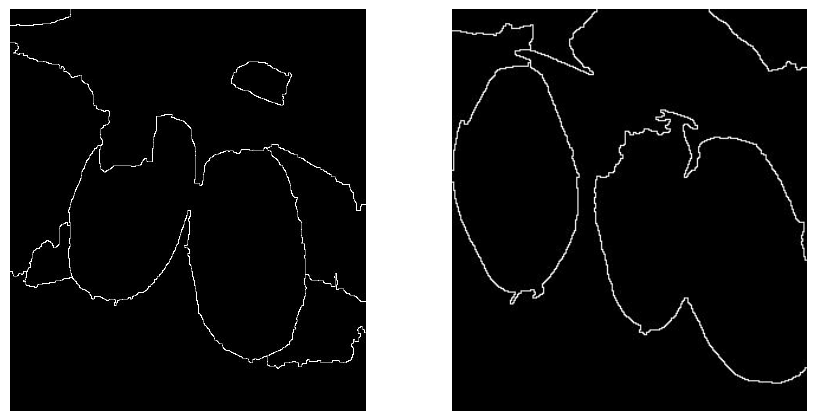
Figure 16. The incorrect result of